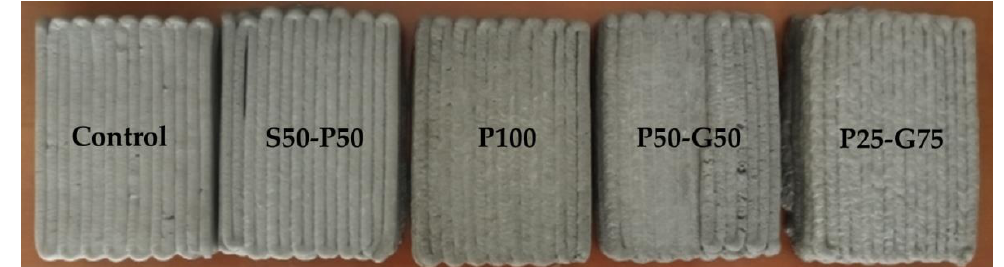
Figure 3. Hardened 3D printed slabs resulting from printability tests.